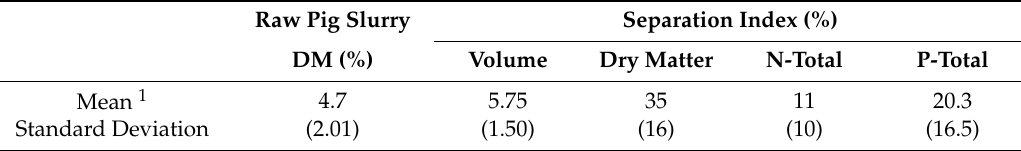
Table 2. Separation indices for mechanical screw press separation